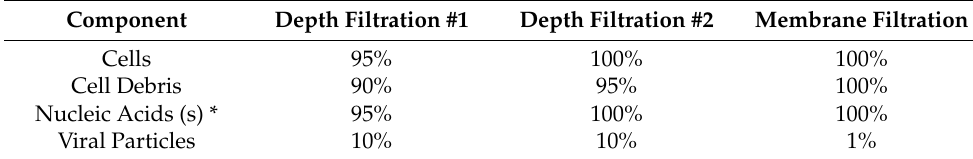
Table 4. Perfusion process cell lysate clarification performance parameters.